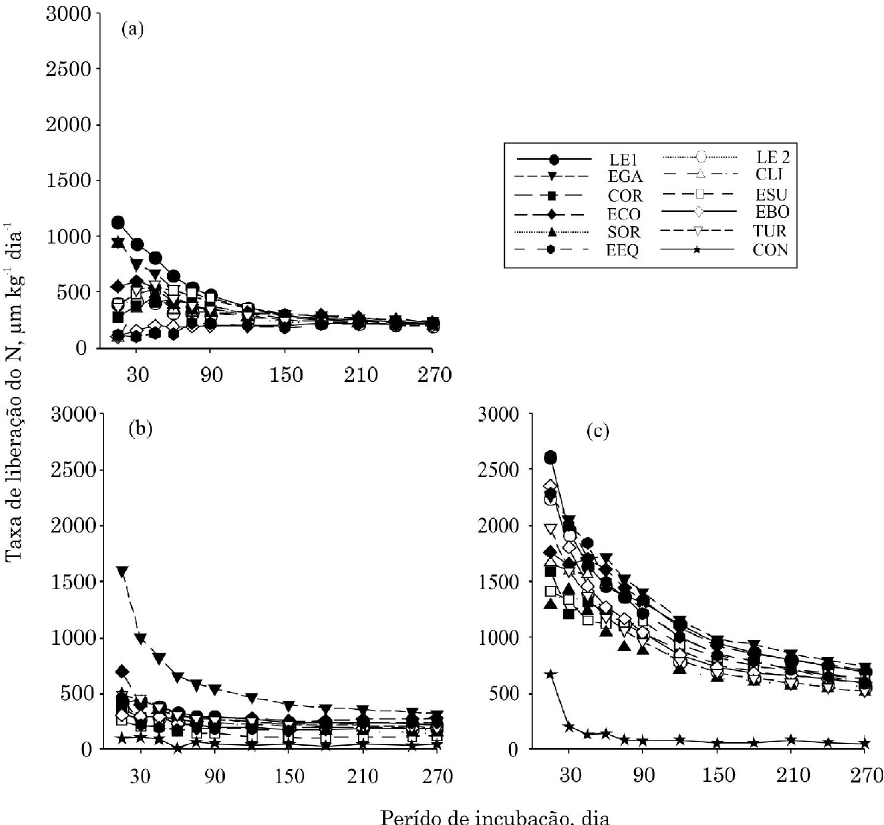
Figura 2. Taxas médias de mineralização diária do N dos resíduos orgânicos incubados com (a) Areia, (b) Latossolo Vermelho-Amarelo e (c) Latossolo Vermelho distroférrico, até os 270 dias de incubação. LE 1: lodo de esgoto 1; LE 2: lodo de esgoto 2; EGA: esterco de galinha; CLI: composto de lixo; COR: composto orgânico; ESU: esterco de suíno; ECO: esterco de codorna; EBO: esterco de bovino; SOR: substrato orgânico; TUR: turfa; EEQ: esterco de equino; e CON: controle (sem adição de